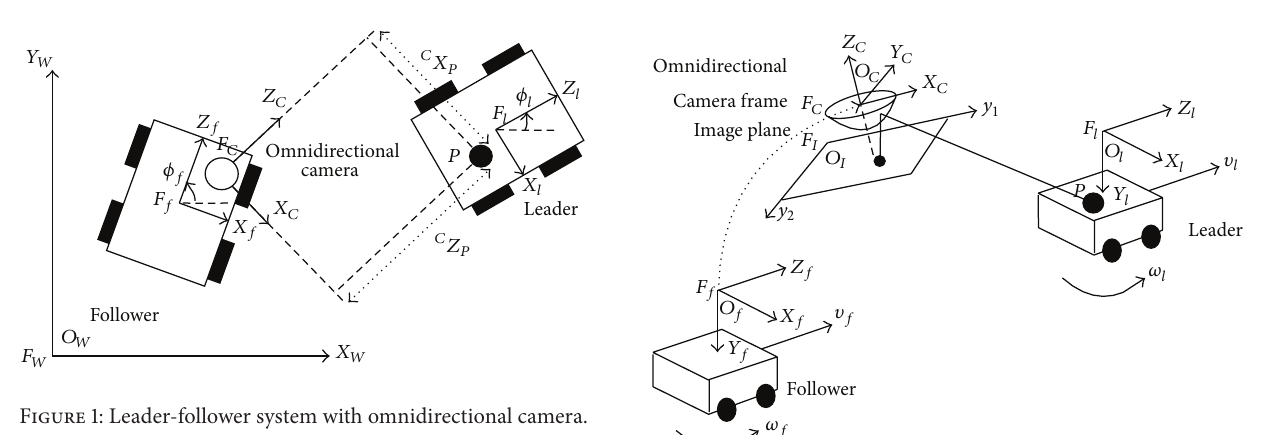
Figure 1: Leader-follower system with omnidirectional camera.